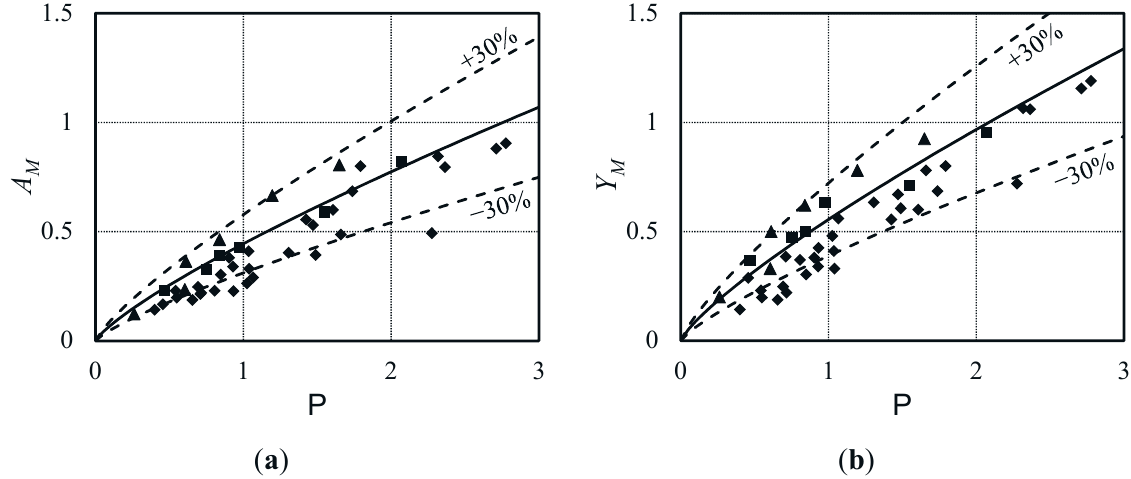
Figure 4. Waves generated by mesh-packed slides ( a ) relative maximum wave amplitude A M ( P ) with ( ─ ) Equation (5); ( b ) wave height Y M ( P ), with ( ─ ) Equation (6) for ( ▲ ) α = 30°, ( ■ ) α = 45°, ( ♦ ) α =